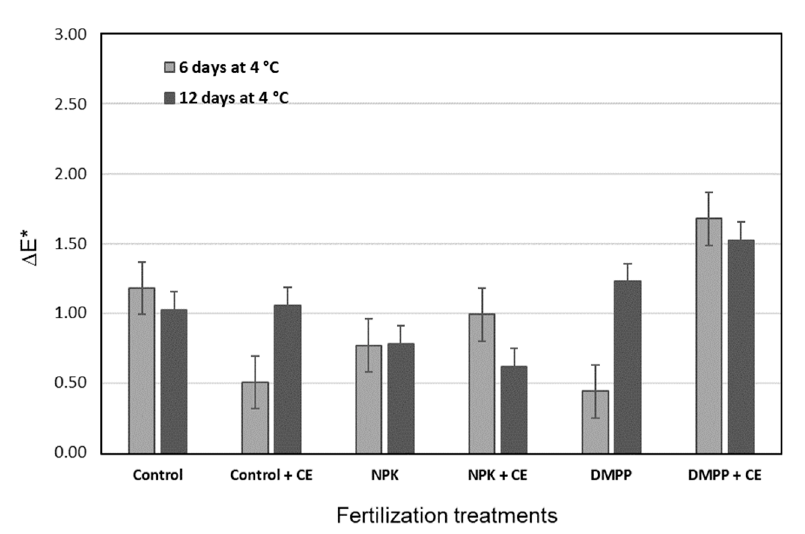
Figure 4. Total color differences ( ∆ E*) of fresh spinach leaves with different fertilizer treatment after 6 and 12 days of storage at 4 °C. Control; Control + CE, control with compost extract; NPK, inorganic NPK fertilizer 15-15-15; NPK + CE, inorganic NPK with compost extract; DMPP, ENTEC Nitrofoska ® plus the nitrification inhibitor (IN) 3,4-dimethylpyrazole phosphate (DMPP); DMPP + CE, the nitrification inhibitor (IN) with compost extract.